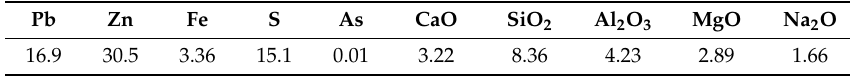
Table 1. Main chemical composition of the oxidizing roasting cinder (wt %).